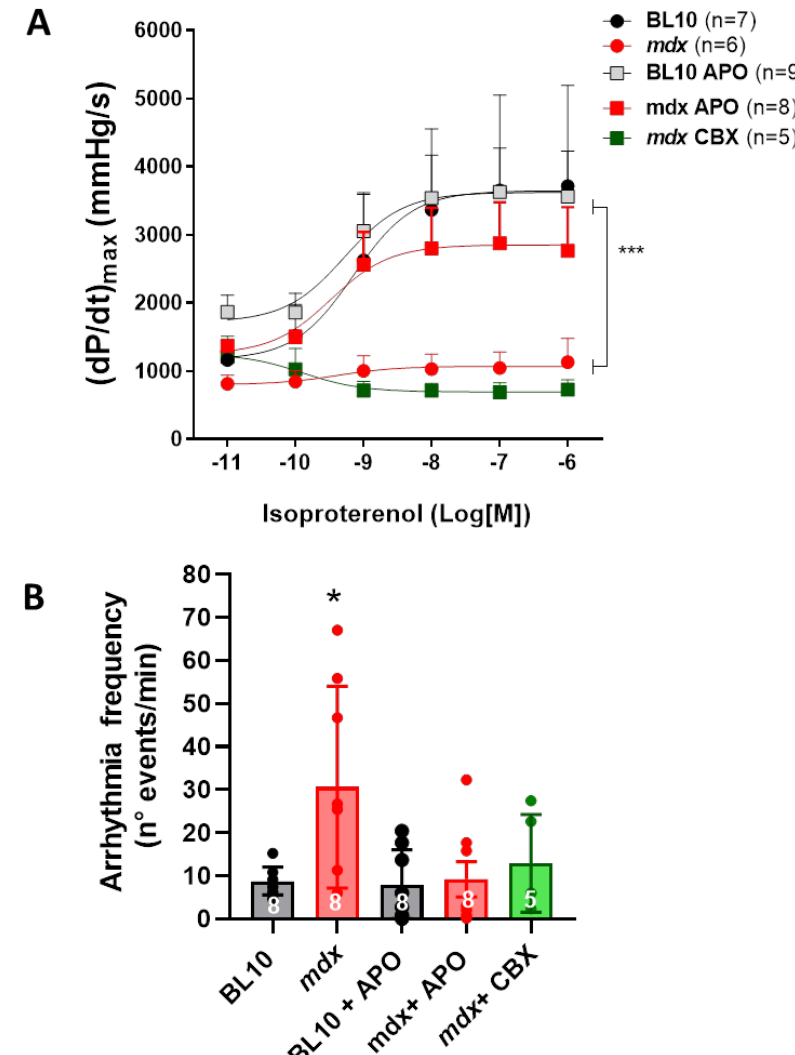
Figure 9. Impact of NADPH oxidase inhibition on cardiac contractility and arrhythmias in dystrophic hearts. ( A ) Graph depicting cardiac contractility evaluated as dP / dt max in response to increasing concentrations of isoproterenol in isolated hearts from 10-month-old control (BL10) and mdx mice, previously treated with the vehicle or apocynin (APO) for one month, or acutely with carbenoxolone (CBX). *** p < 0.001 between the curves indicated by the brackets. ( B ) Analysis of the frequency of arrhythmic episodes in the isolated hearts depicted above. *, p < 0.005 mdx vs. all the other groups, ANOVA with multiple comparisons followed by Neuman–Keuls as post-hoc test.